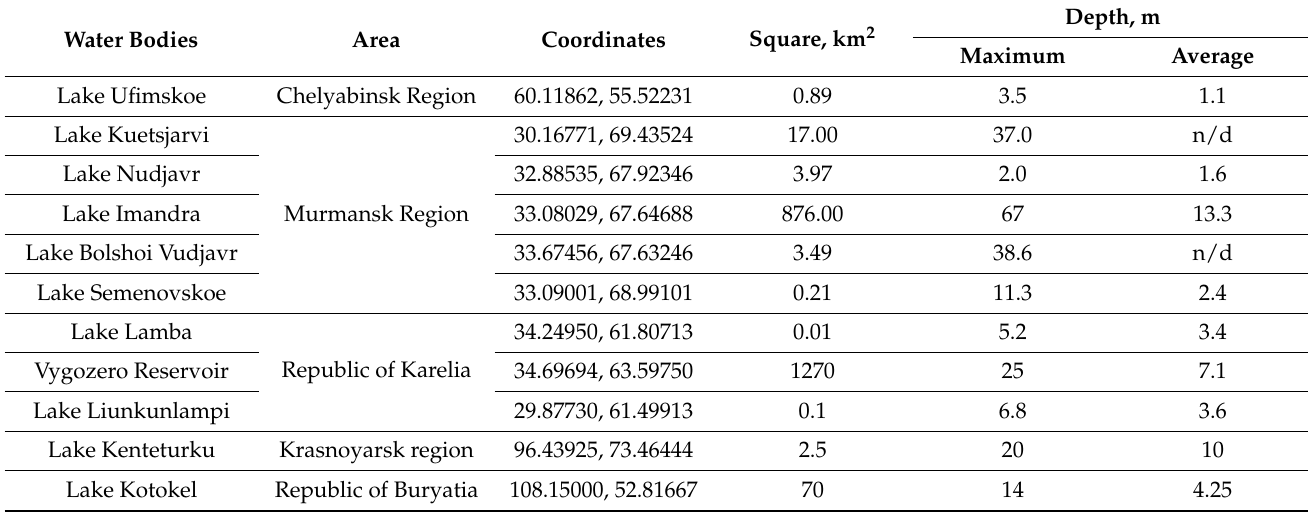
Table 1. Main parameters of water bodies are shown on the map in Figure 1. Note: n/d—there are no